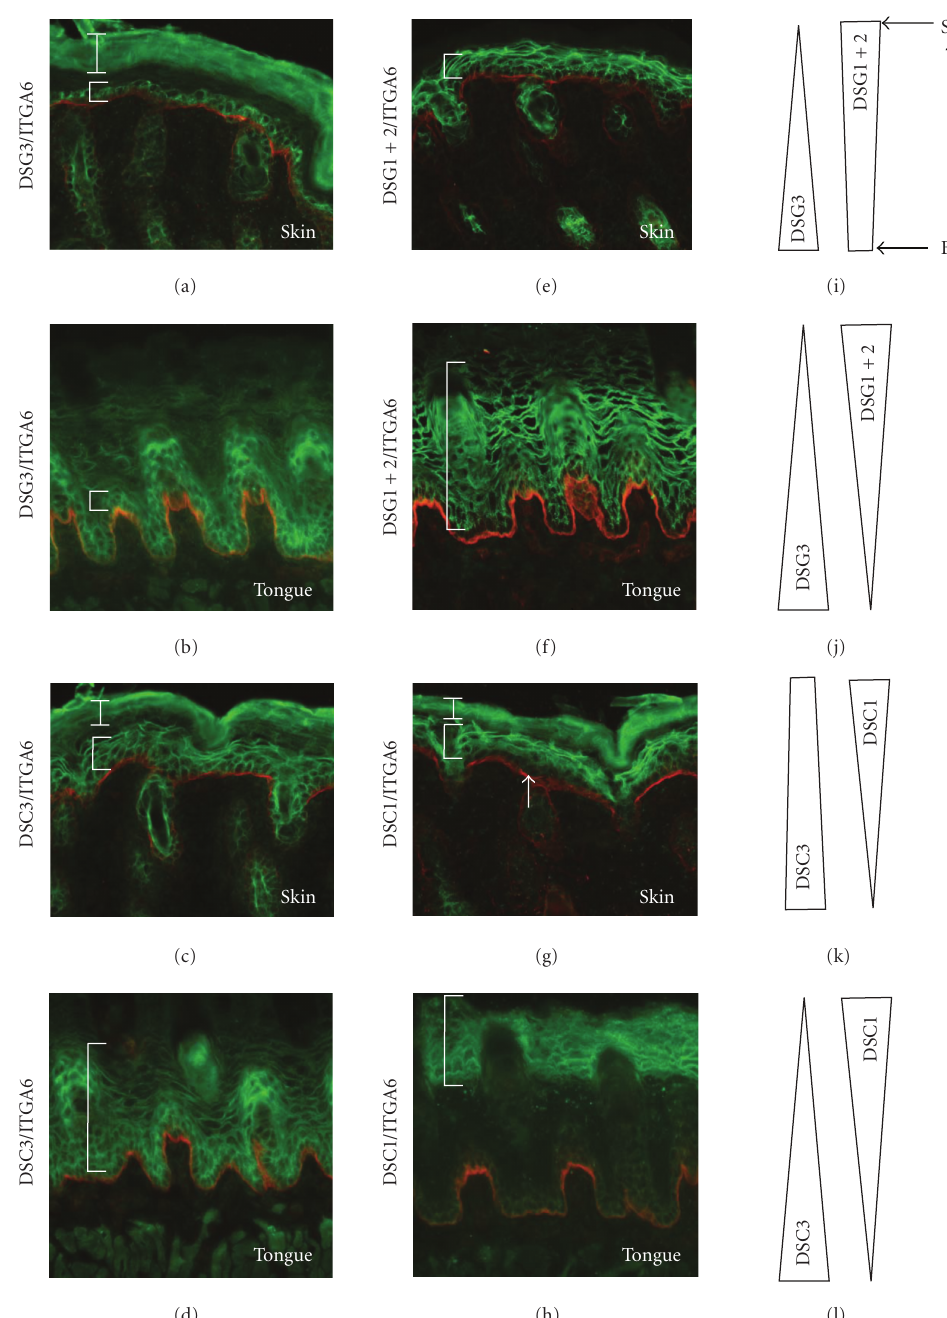
Figure 1: Expression of the desmosomal cadherins desmoglein 1, 2, and 3 (DSG1–3) and desmocollin 1 and 3 (DSC1, 3) as well as α 6- integrin (ITGA6) in the interfollicular epidermis and the tongue epithelium of mice: Immunofluorescence staining of newborn epidermis ((a), (e), (c), (g)) and adult tongue ((b), (d), (f), (h)). The cadherins are shown in green while the integrin is shown in red. ((i), (j), (k), (l)) Schematic representation of the distribution of each desmosomal cadherin in the epidermis ((i), (k)) and tongue epithelium ((j and l)). Note that DSC2 antibodies which recognize the mouse isoform are currently not available (see text for details). Immunofluorescence signals from the stratum corneum are due to nonspecific binding of secondary antibodies ( white bar ). Cell layers expressing the relevant proteins are marked with brackets. The white arrow in (g) points towards the basal layer, which does not synthesize DSC1. Note that the expression of DSG1+2 in the tongue is low in the basal layers. (i, j, k, l) Distribution of the desmosomal cadherins in stratified epithelia (BL, basal layer; SC, stratum corneum). High expression levels are symbolized by a broad base and low expression levels are symbolized by narrow